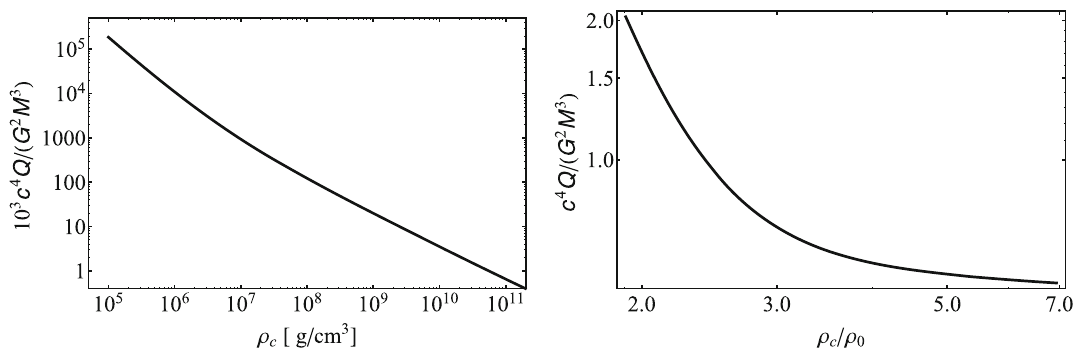
Fig. 1 The mass quadrupole moment Q over the total mass cubed M 3 versus central density ρ c . Left panel: maximally rotating WDs. Right panel: maximally rotating NSs, where ρ 0 is the nuclear density